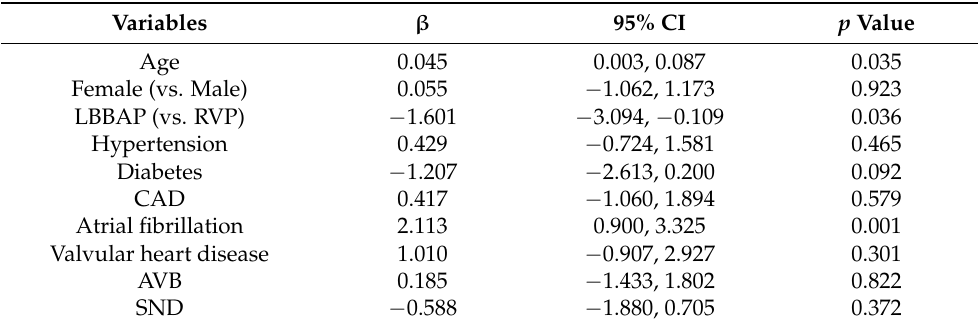
Table 3. Multiple linear regression analysis for the magnitude of delta left atrial diameter ( Δ LAD).